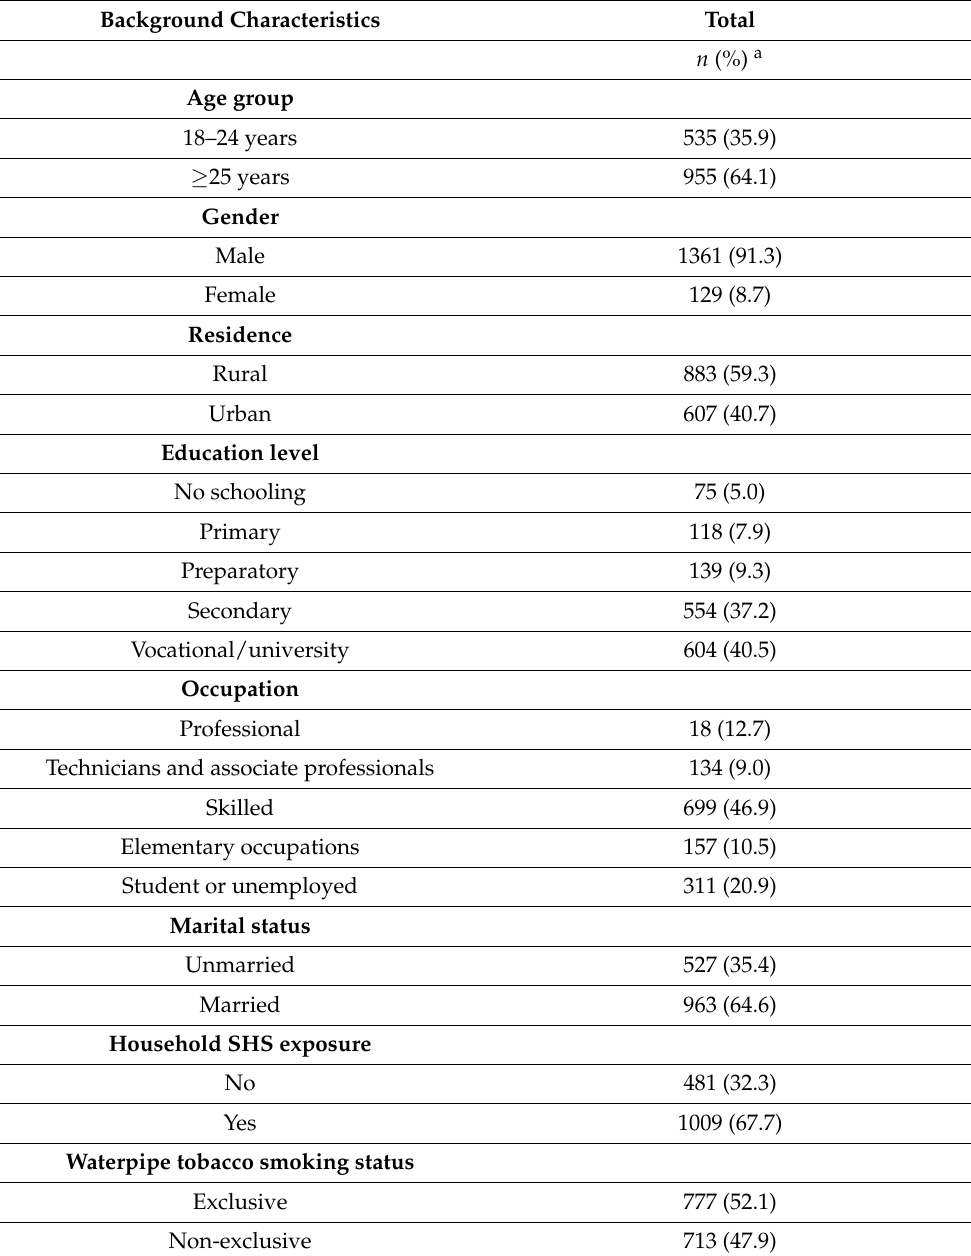
Table 1. Current waterpipe tobacco smokers’ background characteristics, n =